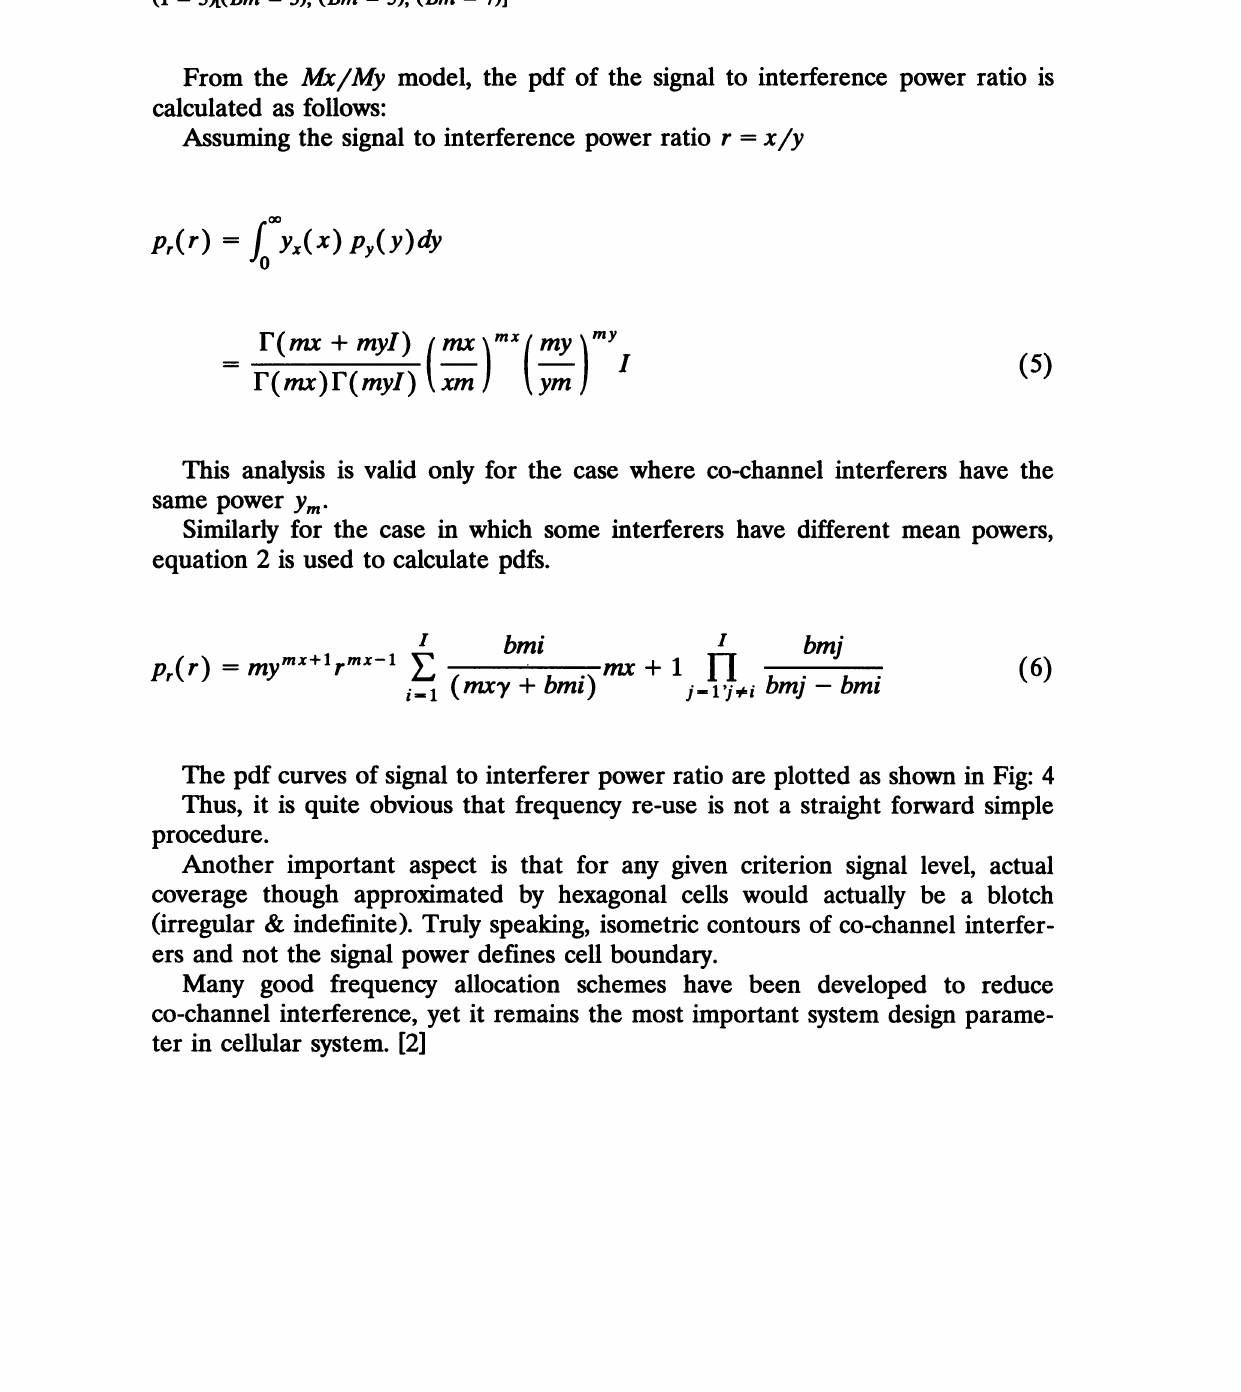
(a) p.d.f, of S/I POWER RATIO My 2(EQUAL MEAN INTERFERENCE POWER) (1-3)(Bin 5) (b) p.d.f, of S/I POWER RATIO My 1 (DIFF. MEAN INTERFERING POWER) (1 3)[(Bin 3); (Bin 5); (Bin